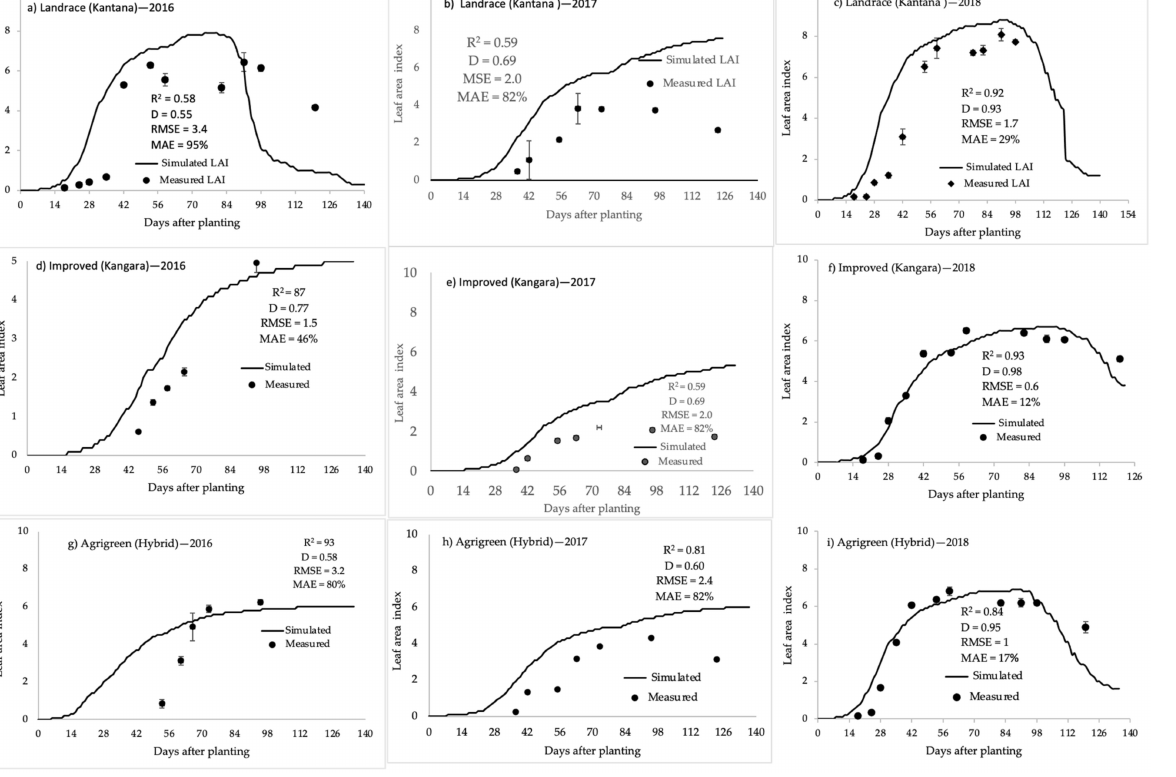
Figure 6. Simulated (solid lines) and measured (points) leaf area index. Landrace (Kantana): ( a ) 2018 rainfed, ( b ) 2017, ( c ) 2018. Improved (Kangara): ( d ) 2016, ( e ) 2017, ( f ) 2018. Hybrid (Agrigreen): ( g ) 2016, ( h ) 2017, ( i ) 2018. All three varieties were irrigated fortnightly excluding ( a